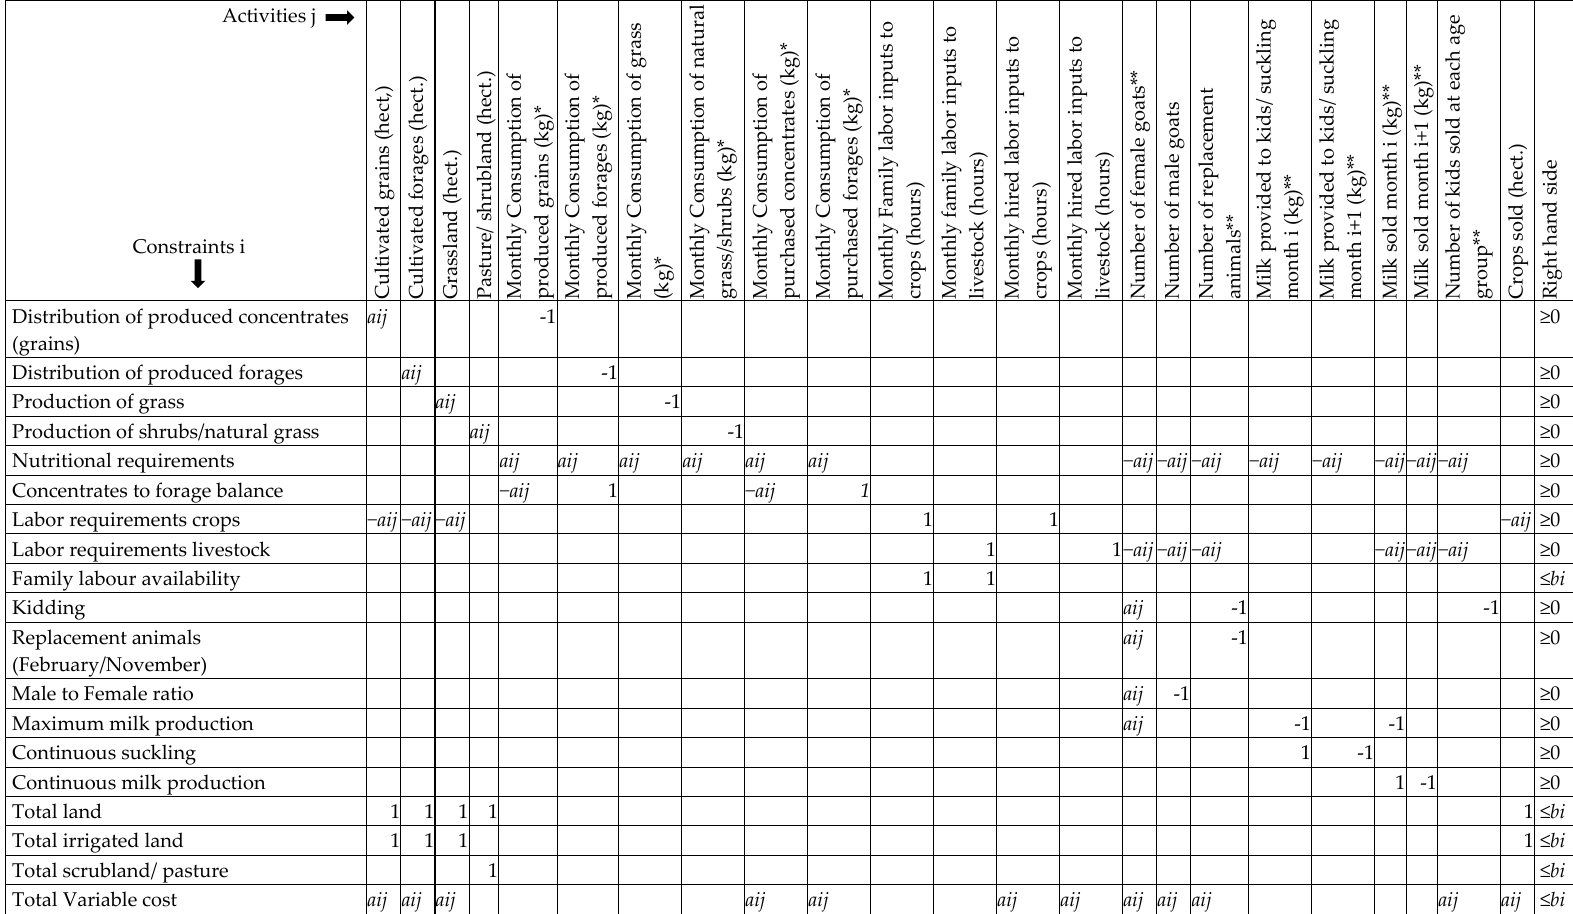
*Total of 24 variables for each feed, 12 for adult animals and 12 for growing animals, **Two variables for each month representing the two alternative kidding periods Figure 1. Representation of the original linear programming model. Figure 1. Representation of the original linear programming